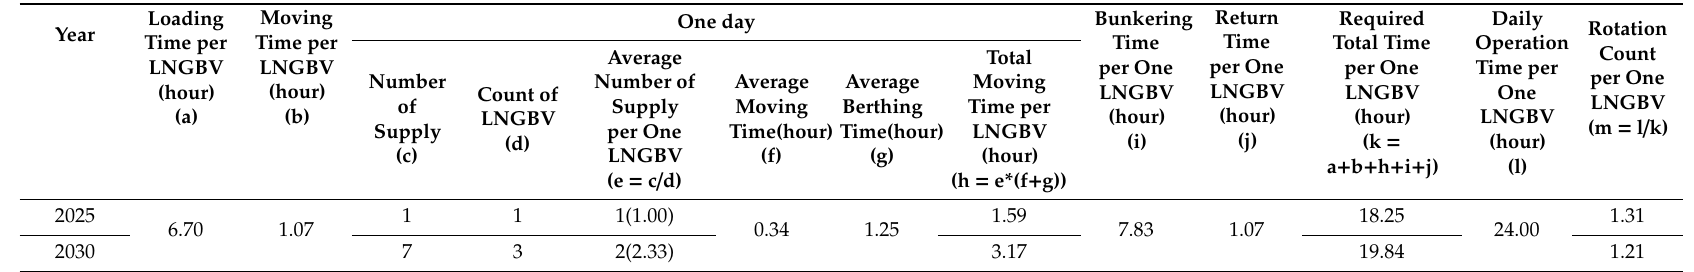
Table A11. Estimated Total Time and Number of Rotation per One STS Bunking.